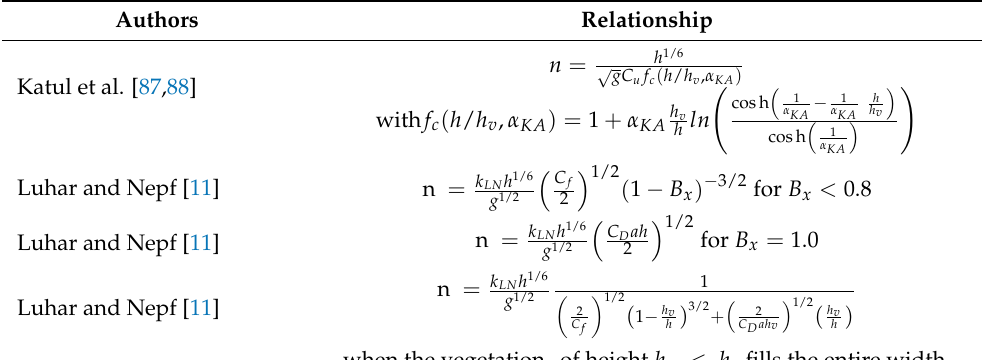
Table 3. Equations for estimating n in case of submerged and emergent rigid